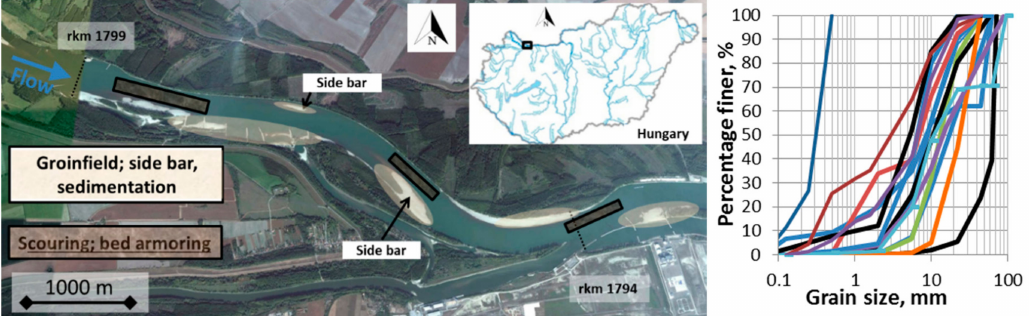
Figure 1. The sketch of the investigated Danube study reach ( left ) and grain size distributions taken from the investigated reach ( right ). The characteristic water discharges are mean flow Q m = 2000 m 3 / s, range of bankfull discharge Q bf = 4300–4500 m 3 / s, 2, 10 and 100-year flood event Q 2 = 5950 m 3 / s, Q 10 = 7950 m 3 / s and Q 100 = 10,400 m 3 / s